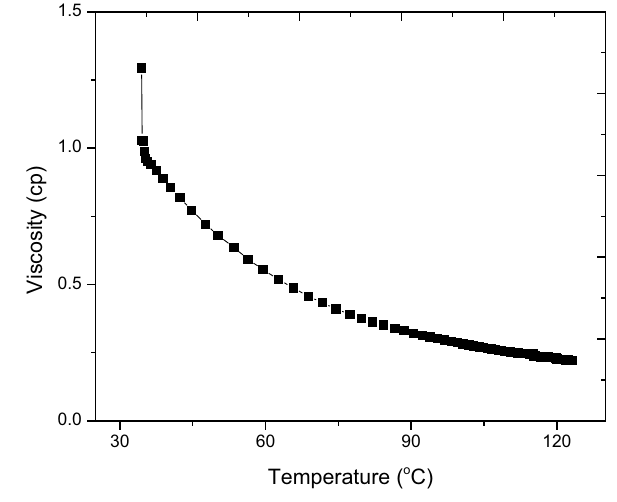
Fig. 7 Influence of pressure and temperature on the viscosity of the MFomax/SiO 2 -KH550 NF ramped from 30 to 125 °C and 2023 psi